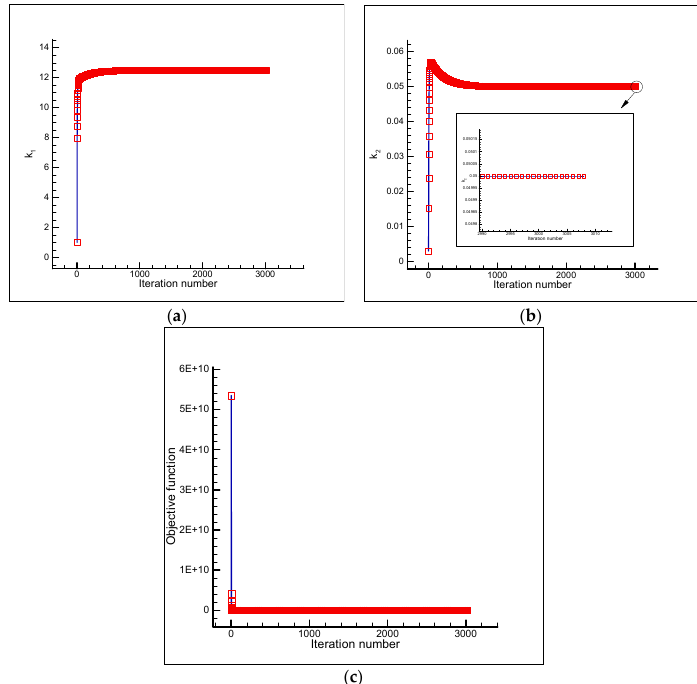
Figure 13. Estimation of k 1 ( a ) and k 2 ( b ), and the objective function versus iteration number ( c ) using the initial guess = 1.0 + 0.003 T ( W ) and a single sensor placed at the node ( i , j ) = ( 3,12 ) .